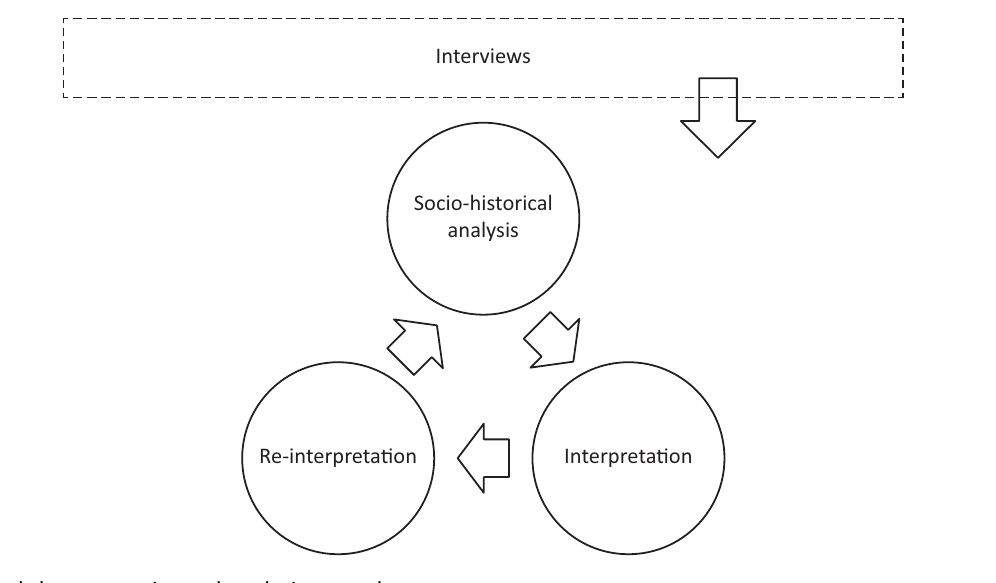
Figure 1. Depth‐hermeneutics and analysis